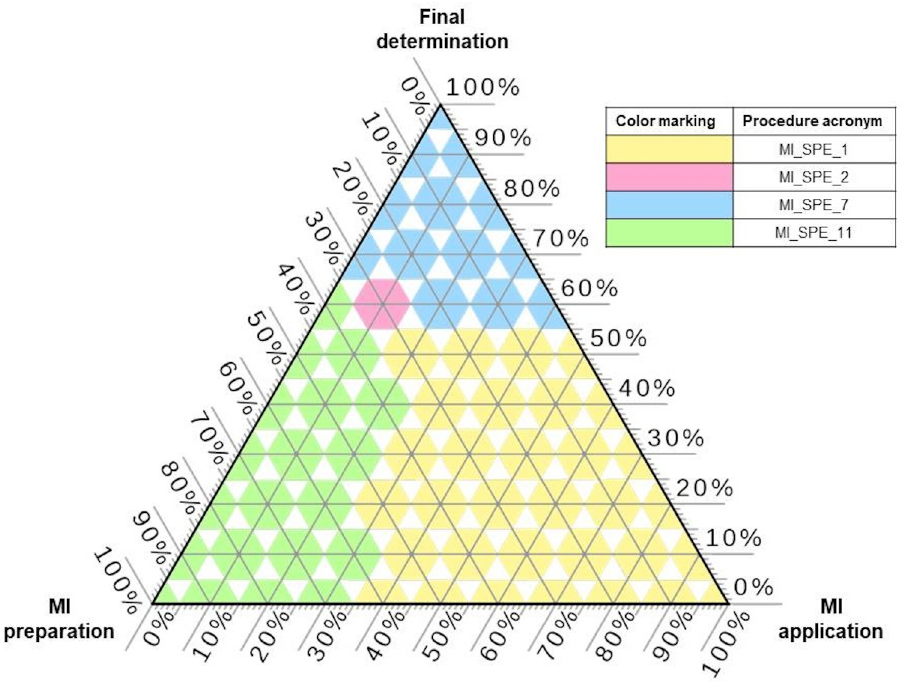
Figure 4. The winning procedures based on MI-SPE according to TOPSIS rankings for different weights